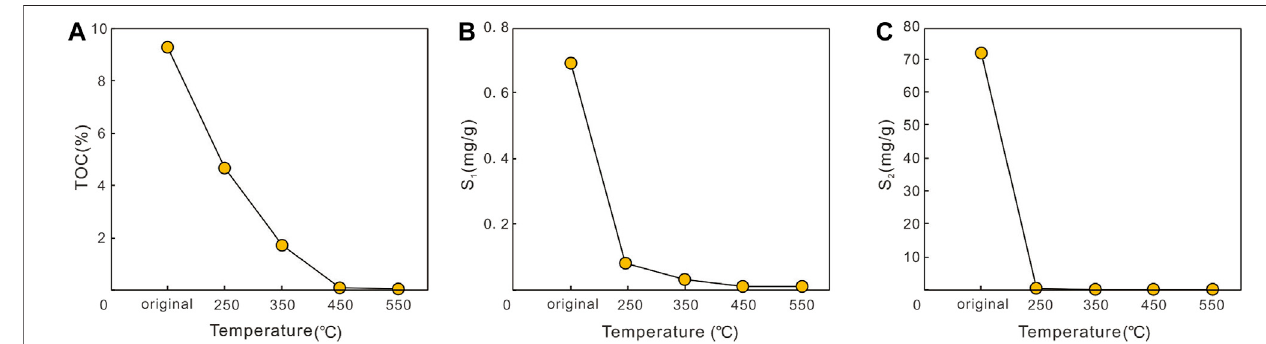
Frontiers in Earth Science |